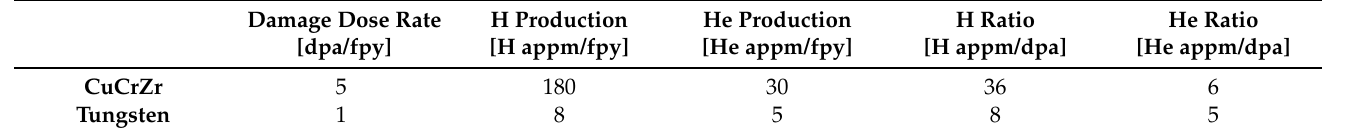
Table 5. Damage dose, production and ratio of H and He in the divertor. Adapted from Ref. [131]. Credit c (cid:13) IOP Science, 2017.